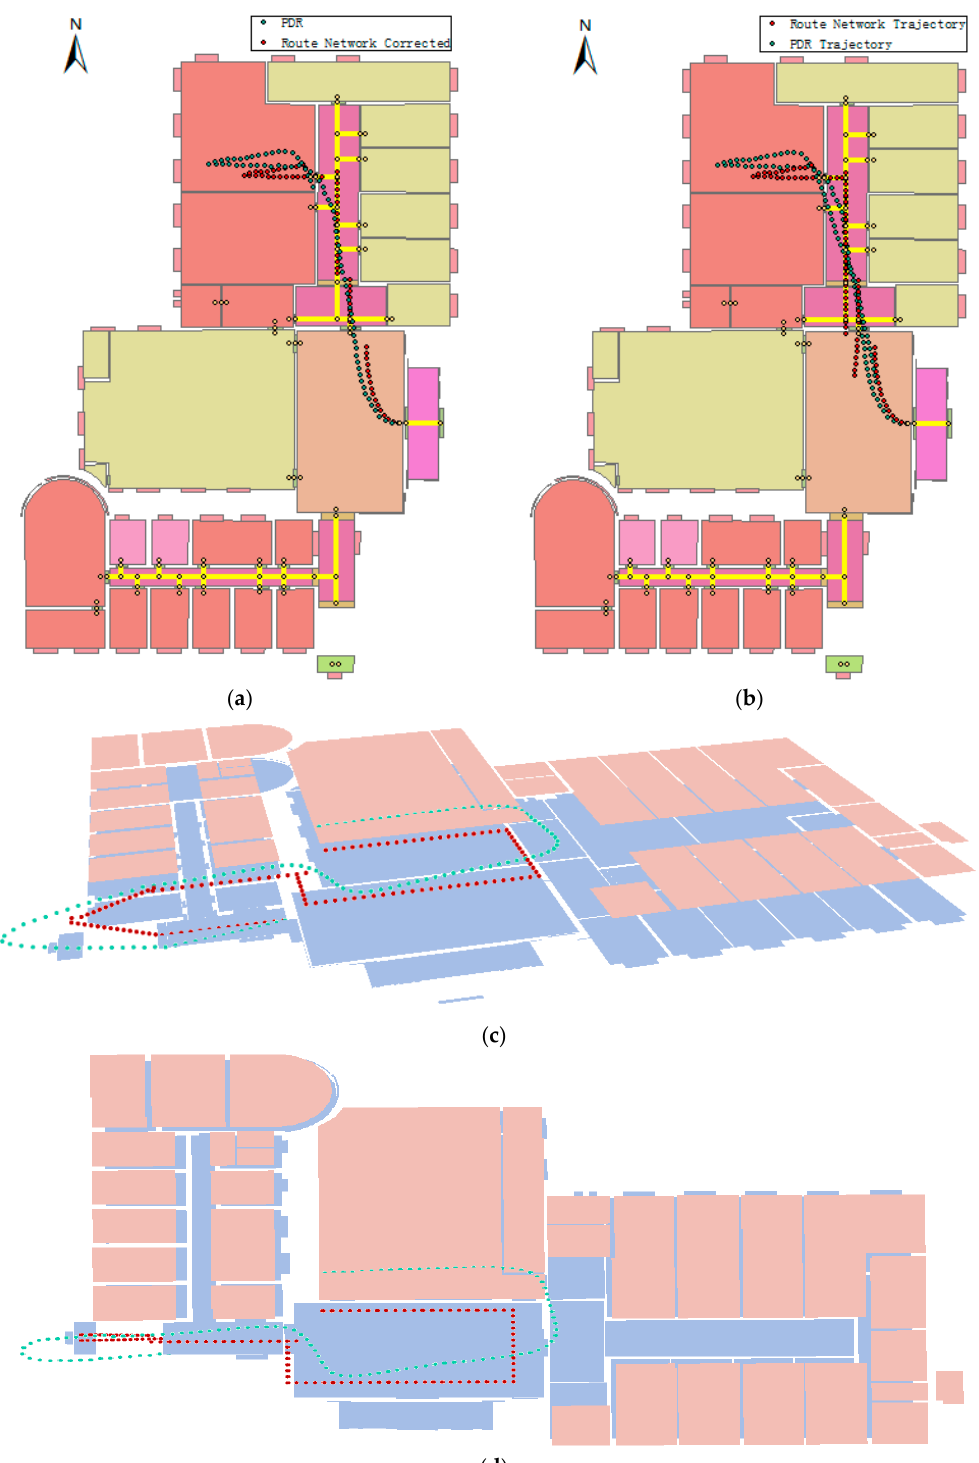
Figure 10. Localization result: ( a ) the first half trajectory of experiment 1; ( b ) the whole trajectory of experiment 1; ( c ) the side-look graph of going upstairs in experiment 2; ( d ) the overlook graph of the trajectory when walking in the lobby in experiment 2.